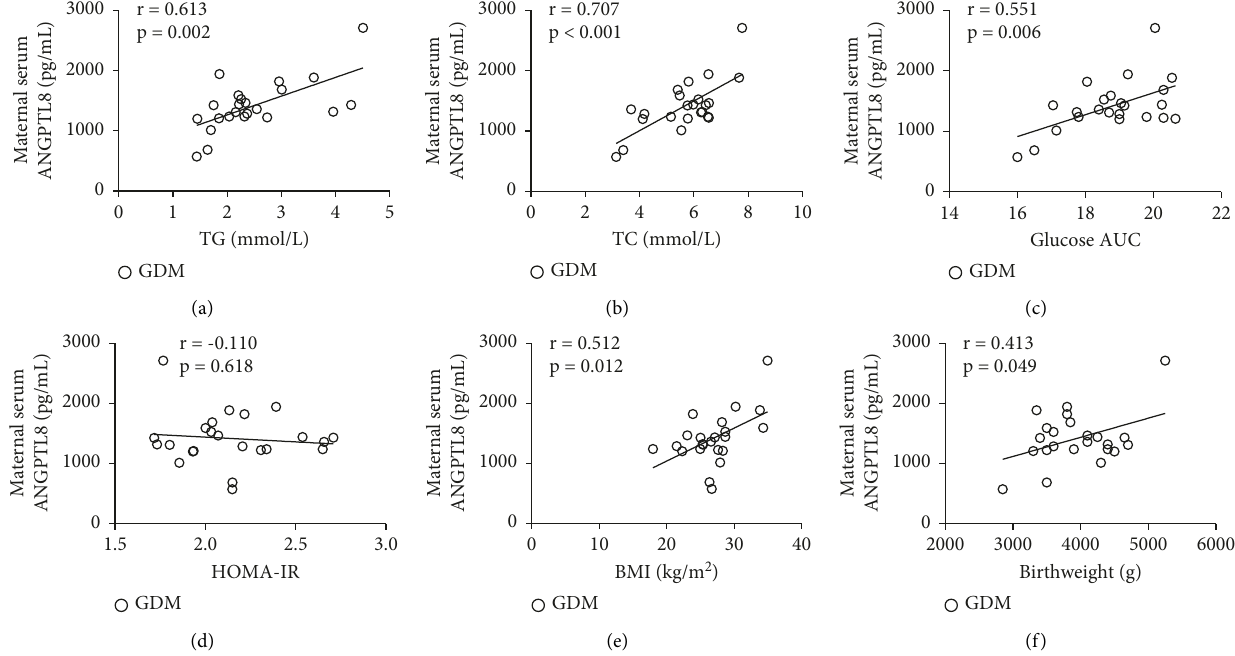
Figure 3: Correlation analysis between maternal serum ANGPTL8 and metabolic parameters of pregnant subjects with diabetes mellitus. (a) Correlation between ANGPTL8 and TG levels. (b) Correlation between ANGPTL8 and TC levels. (c) Correlation between ANGPTL8 and AUC for OGTT. (d) Correlation between ANGPTL8 and HOMA-IR. (e) Correlation between ANGPTL8 and BMI. (f) Correlation between ANGPTL8 and birthweights.